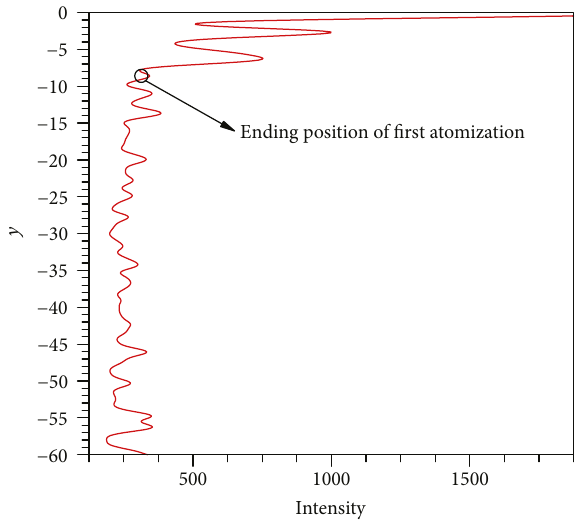
Figure 10: The average light intensity ( I distance ( y